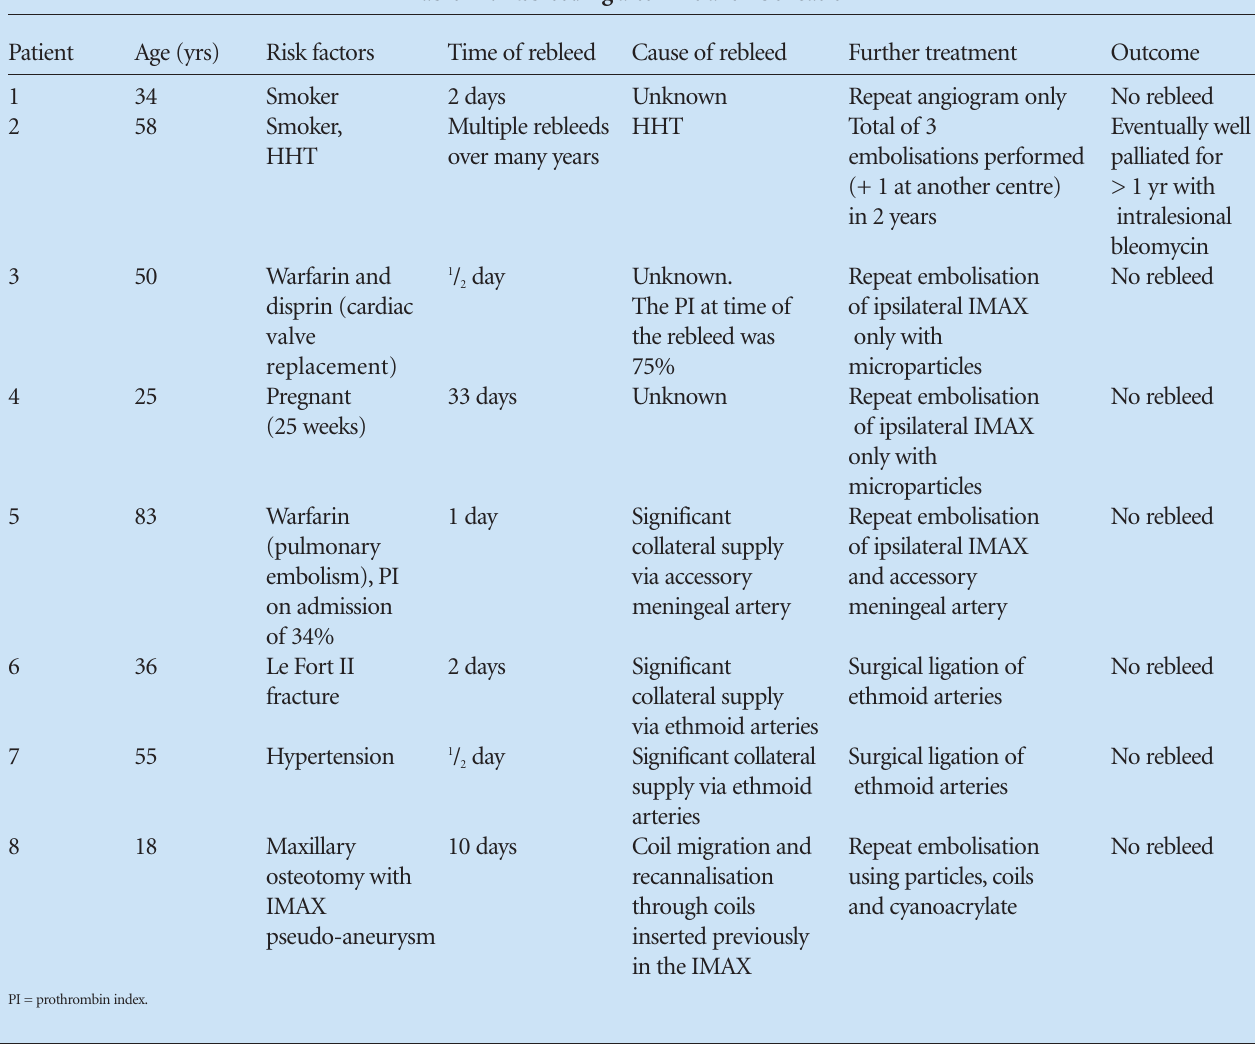
Table III. Rebleeding after initial